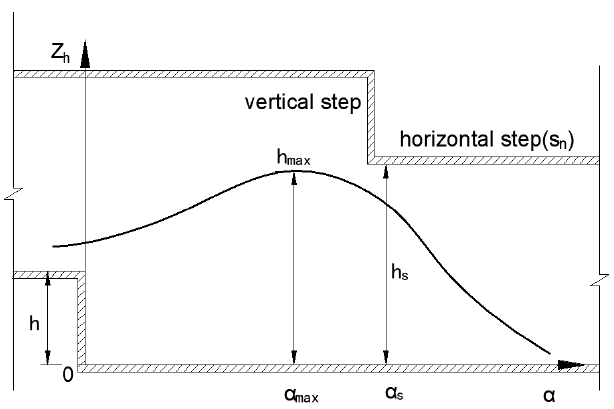
Figure 10. Water depth along the external wall.